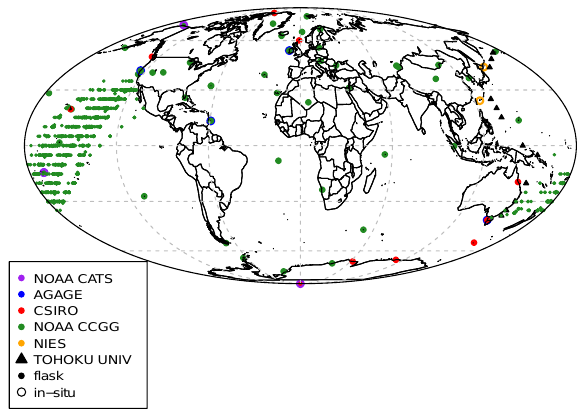
Fig. 1. Map of observation sites and ship tracks by network.